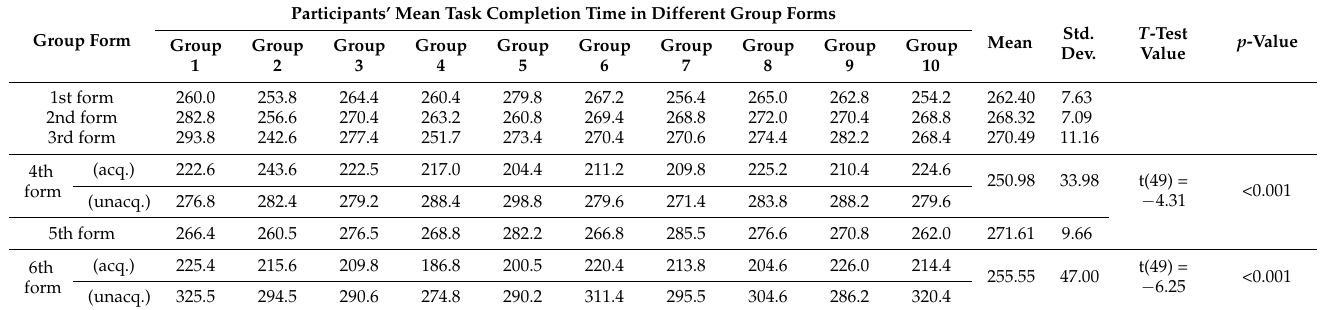
Table 5. Task completion time in different